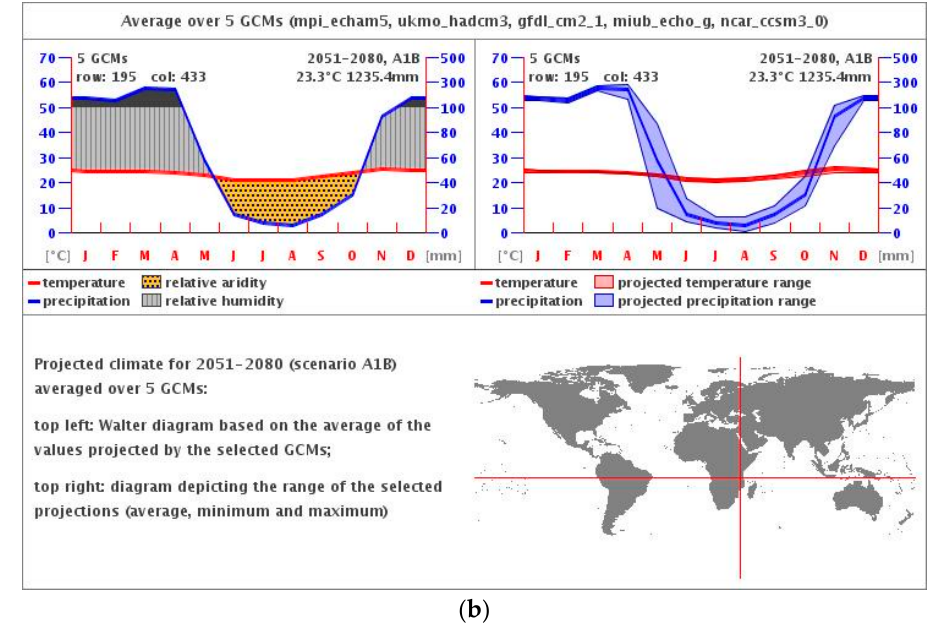
Figure B2. Projected climate for the UMNP for the period 1991–2020 ( a ) averaged over 5 Global Circulation Models (GCMs) on top and for the period 2051–2080 ( b ) at the bottom.